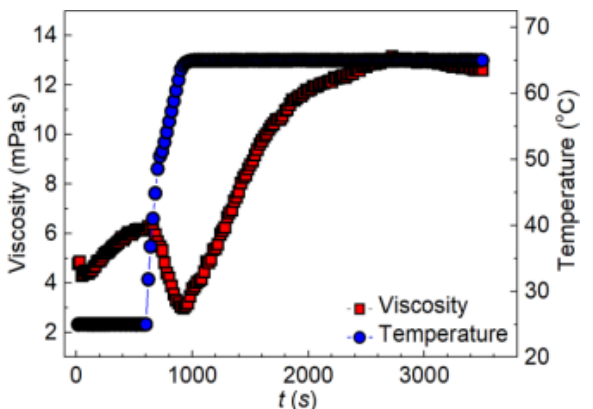
Fig. 4. Change of constant shear rate (7.34 s-1) viscosity of samples diluted at room temperature with time after